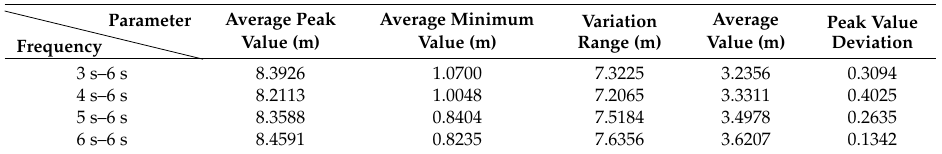
Table 5. Pressure values and statistical analysis after air inflow has been cut off for 6 s (rectangular nozzle in the middle of the pipe).